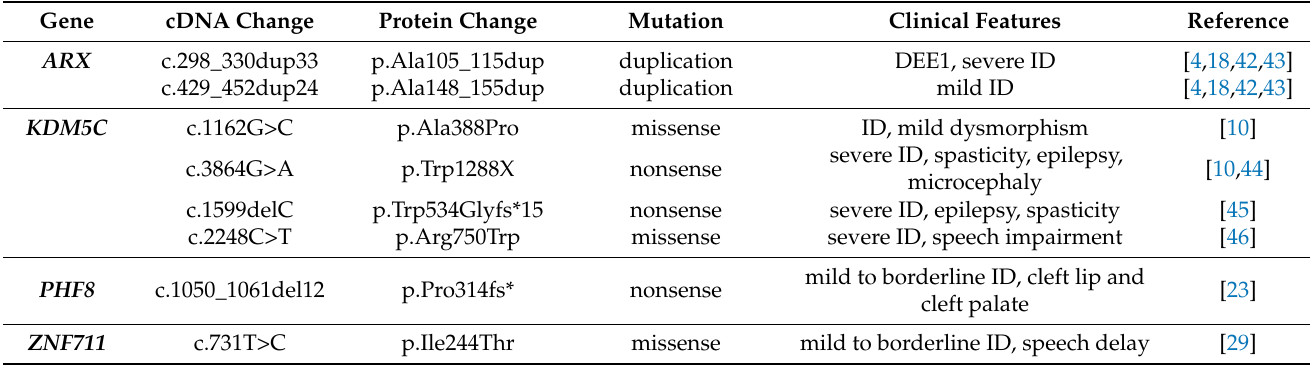
Table 1. List of disease mutations analyzed in this